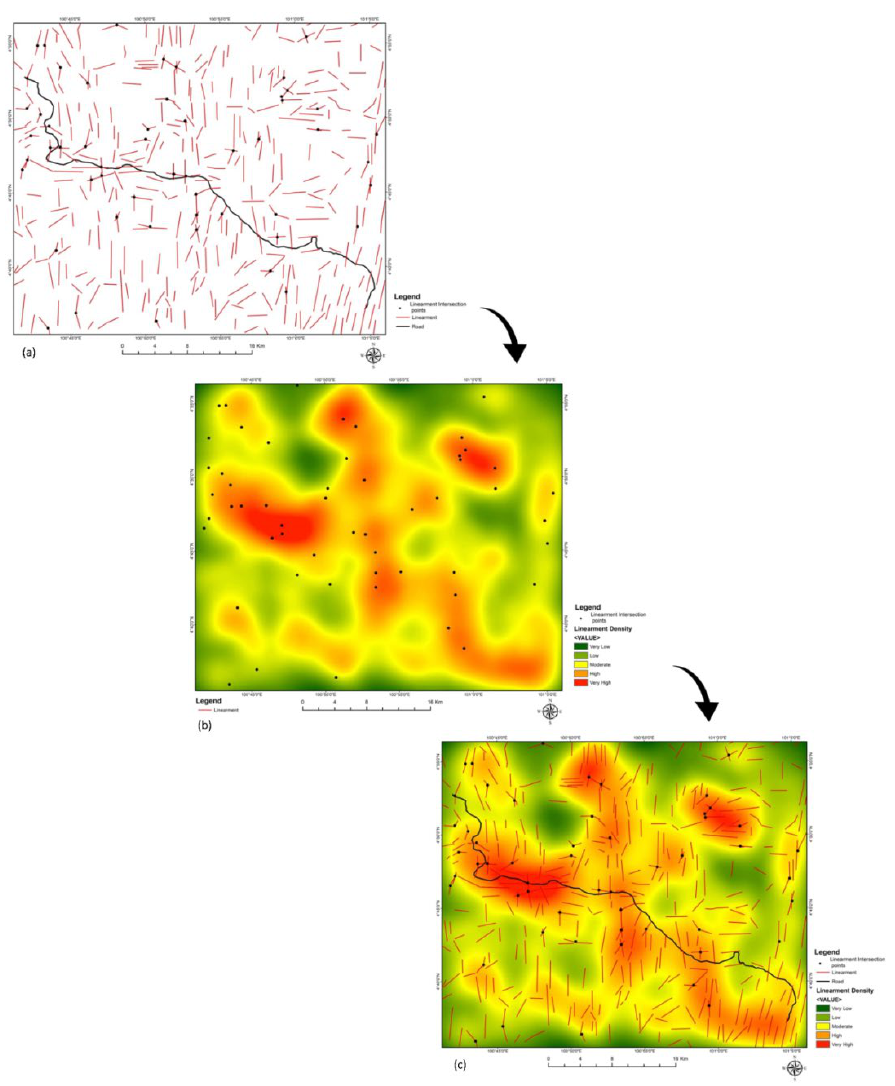
Figure 6: Lineament intersection maps (a) Showing crosscutting relationship with road under study (b) Showing Lineament density map and classes (c) Final output integrating lineament intersection and density map with road